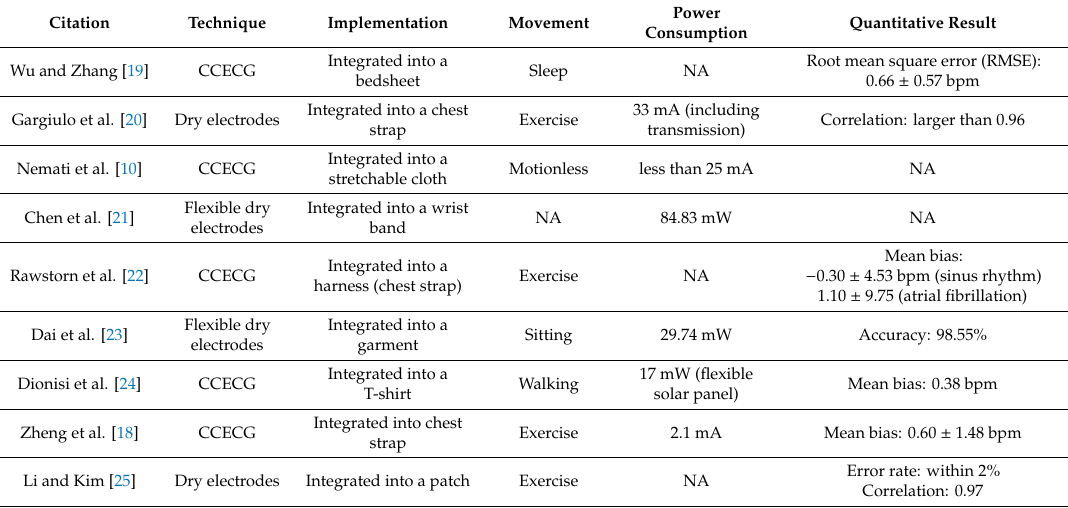
Table 1. Summary of electrocardiography (ECG)-based techniques for HR